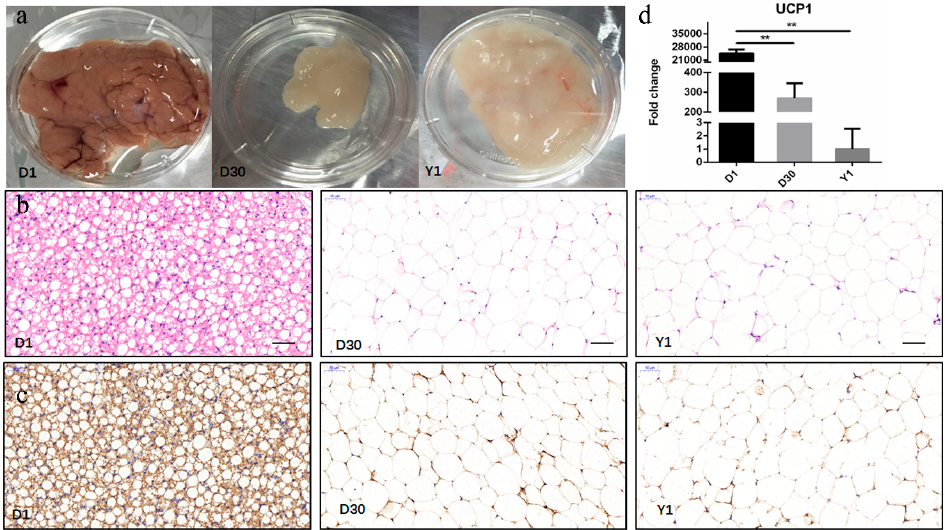
Figure 1. Characterization of transformation from brown adipose tissue (BAT) to white adipose tissue (WAT) during perirenal fat development. ( a ) Representative images are shown for goat perirenal fat 1 day (D1), 30 days (D30), and 1 year (Y1) after birth of the goat. ( b ) Histological sections stained with hematoxylin (HE). ( c ) Uncoupling protein 1 (UCP1) immunostaining from perirenal adipose tissue at three stages. Scale bars: 50 μ m. ( d ) Changes in mRNA expression levels of UCP1. Error bars represent standard error of mean (SEM), n = 4 **, p < 0.01.